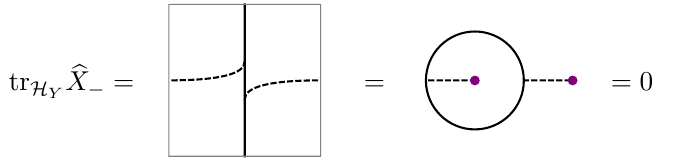
Figure 49 . Vanishing tr H b X (cid:0) . The (cid:12)rst picture represents the torus partition function with a Y temporal Y loop (solid), and a spatial X line (dashed). The second picture represents a two-point function of the defect operator a 2 H X connected to a Y loop through X lines. If the operator a lying outside is brought around the circle, a minus sign is acquired when the two XY Y junctions cross one another, due to the crossing phase e K Y;X ( Y; Y ) = (cid:0) 1. Therefore, the correlator X;Y